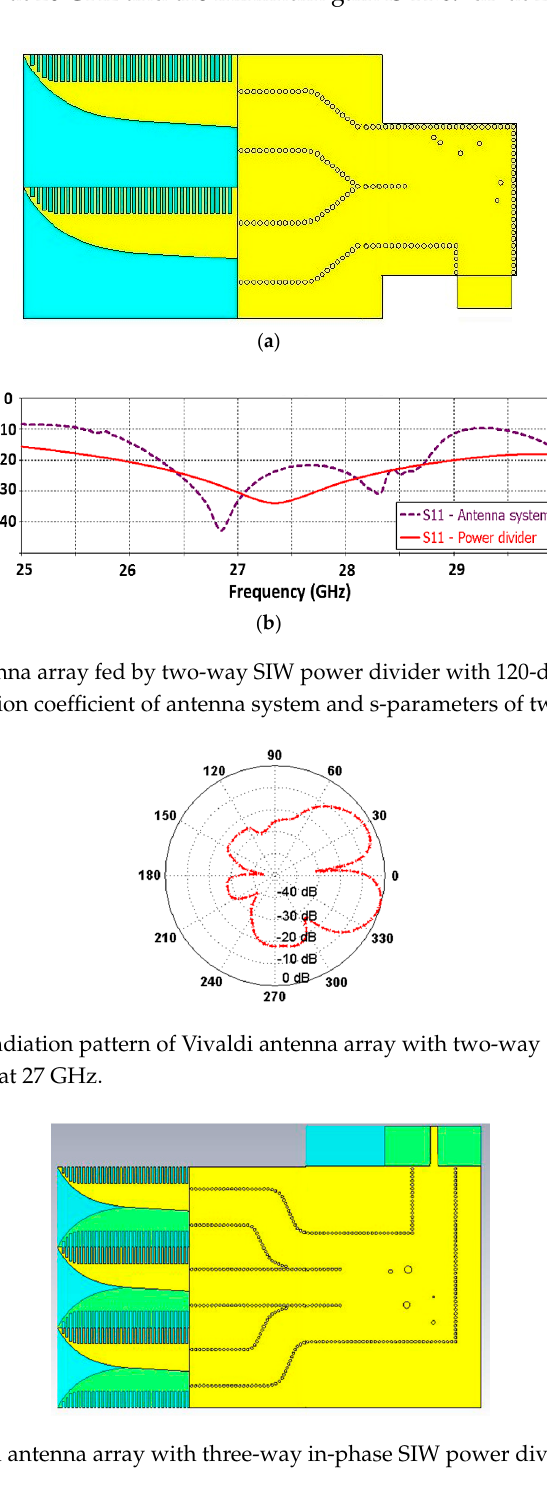
Figure 12. Comparison between measured and simulated far-field radiation pattern of H-plane SIW antenna array with two-way 180-degree out-of-phase power divider at ( a ) 26.5 GHz ( b ) 27 GHz, and ( c ) 27.5 GHz .